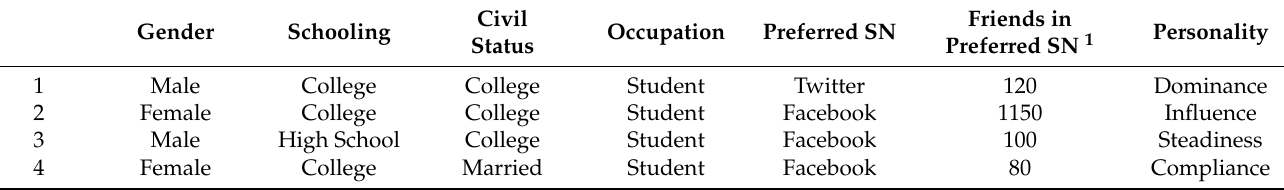
Table 2. Examples of answers of the participants in the survey.